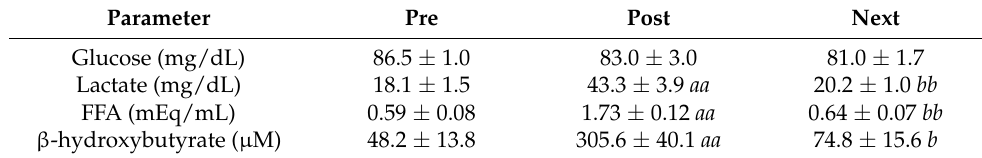
Table 1. Serum levels of biochemical energy-related parameters before and after the